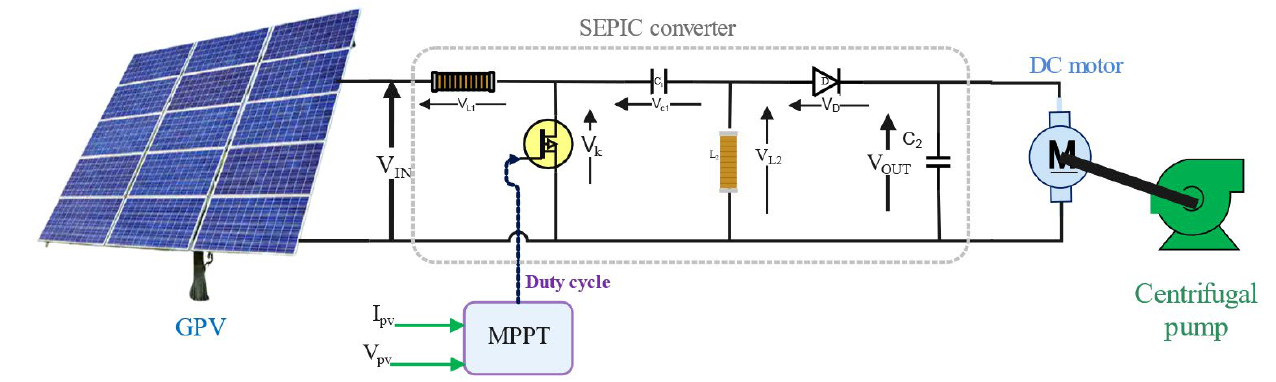
Figure 5. Solar water pumping system optimization structure.